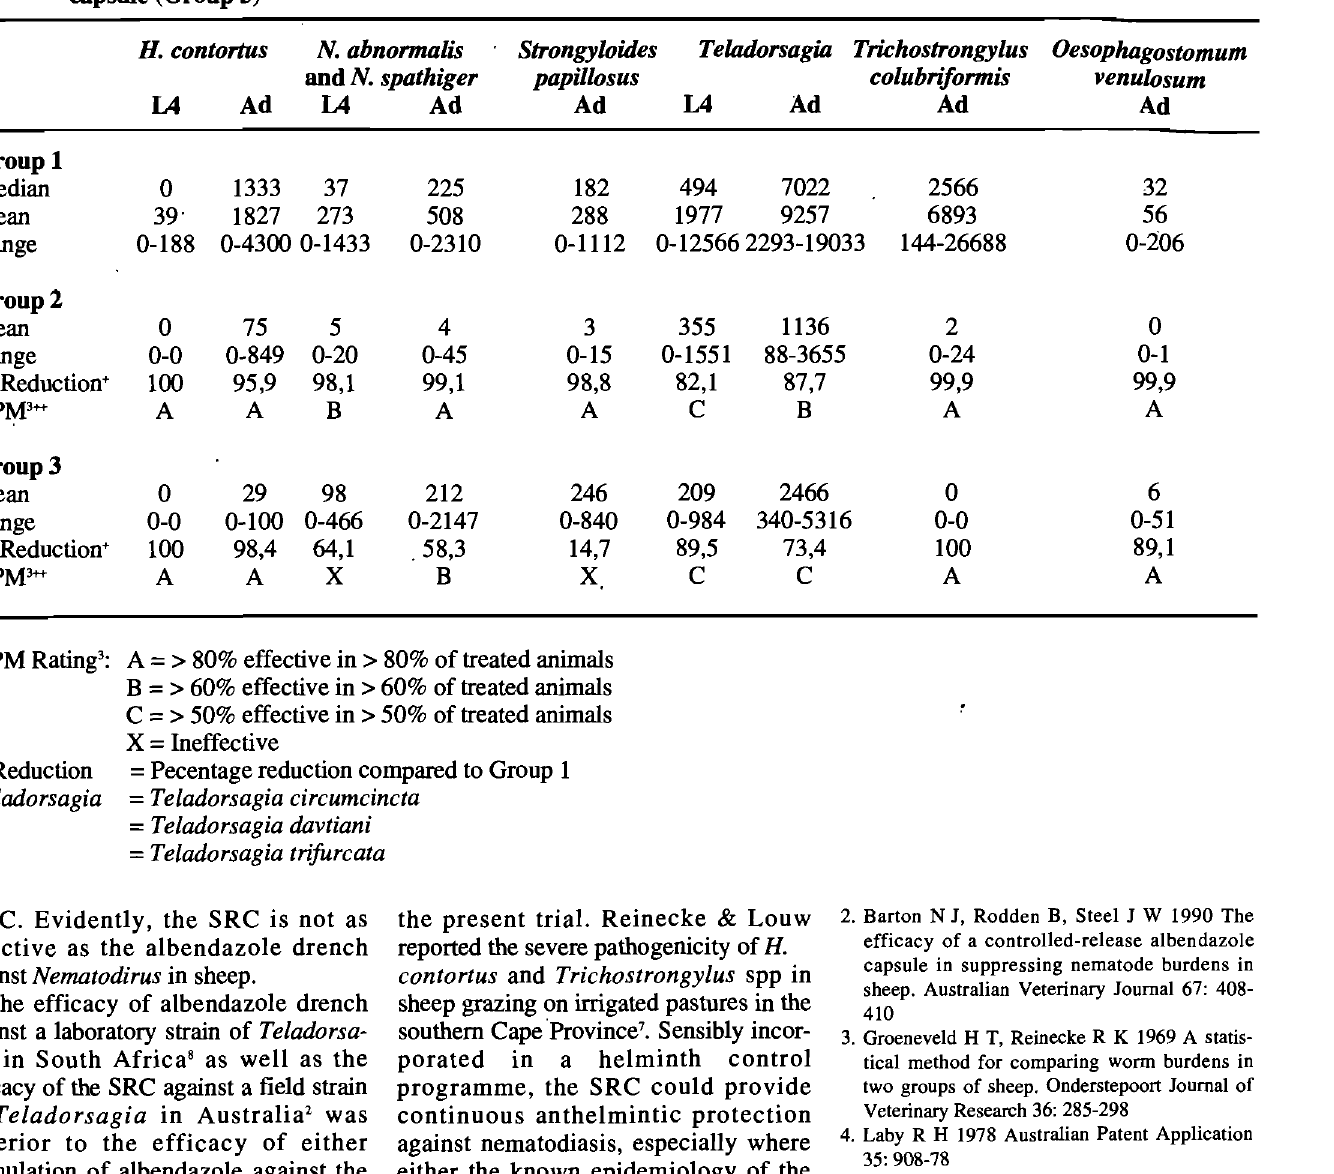
Table 2: Median, mean, range and reduction of the number of nematodes recovered from control sheep (Group 1), sheep dosed withalbendazole (Group 2) and sheep dosed ,,:ith an albendazole intra-ruminal slow-release capsule (Group